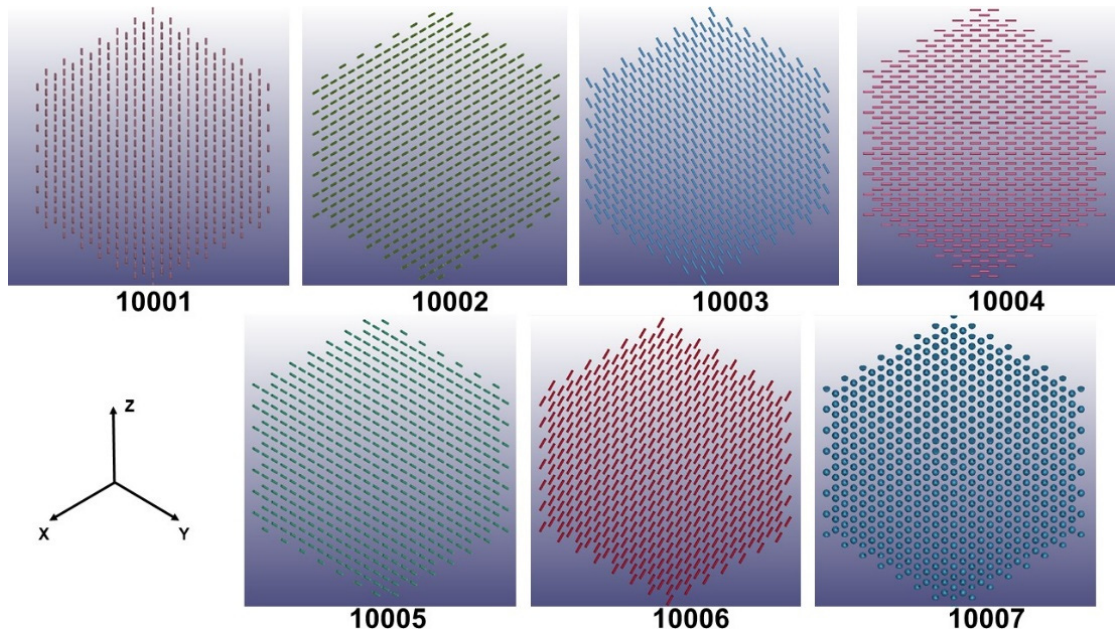
Figure 11. Local coordinate systems for bodies in the digital twin CAD model based on their orientation angle, and numbered from 10001 to 10006. All nodes were assigned the 10007 orientation.